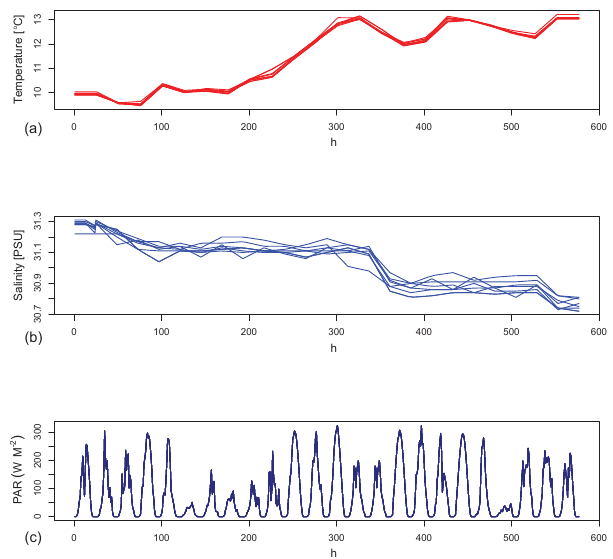
Figure 1. Forcing variables for all nine mesocosms: (a) shows tem- perature, linearly interpolated to hourly values between daily obser- vations. (b) Displays hourly interpolated salinity values, and (c) re- veals the irradiance data with hourly temporal variations